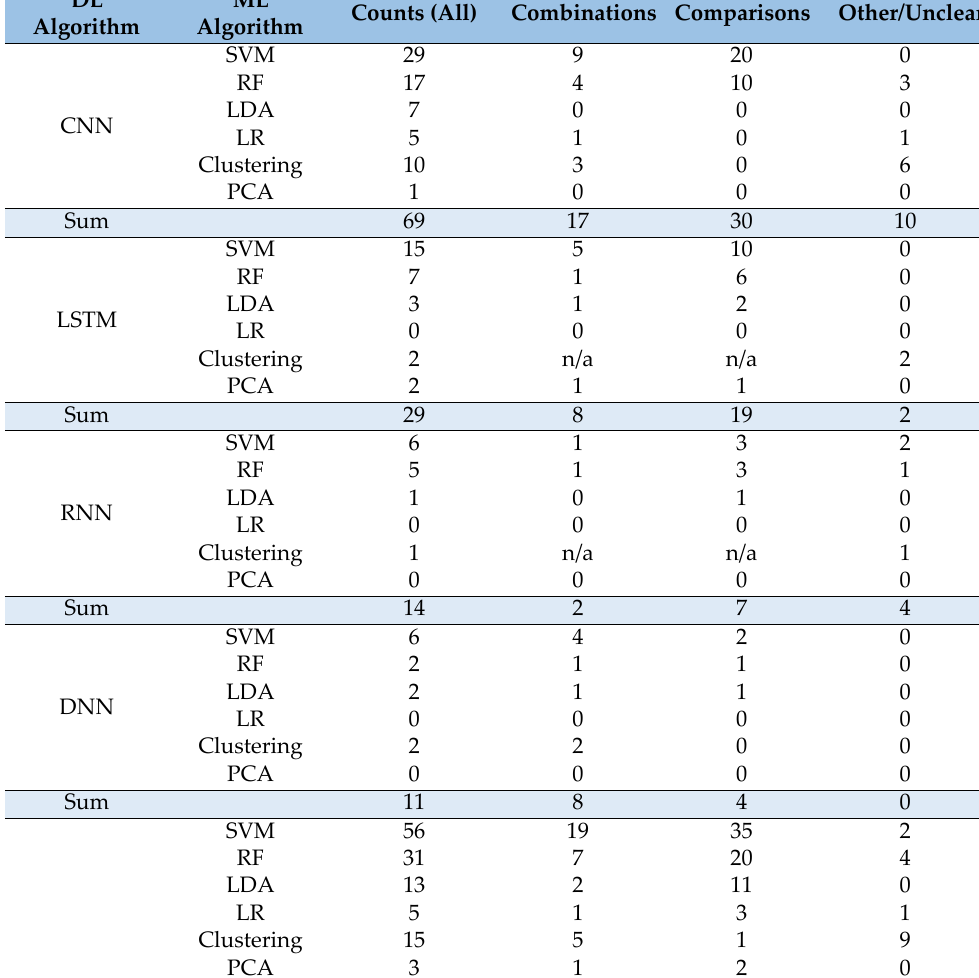
Table 1. Combinations and comparisons of ML and DL algorithms (A) located in PubMed‑indexed papers using the search terms ‘EEG AND [ML A] AND [DL A].’ Combination and comparison counts were taken from study abstracts. Where this classification was not obvious, counts are included in the ‘Other/Unclear’ column. Abbreviations used: CNN: Convolutional Neural Network; DNN: Deep Neural Network; LDA: Linear Discriminant Analysis; LR: Logistic Regression; LSTM: Long Short‑Term Memory; PCA: Principal Component Analysis; RNN: Recurrent Neural Network; SVM: Support Vector Machine. These terms are explained in more detail in the online Supplementary Materials